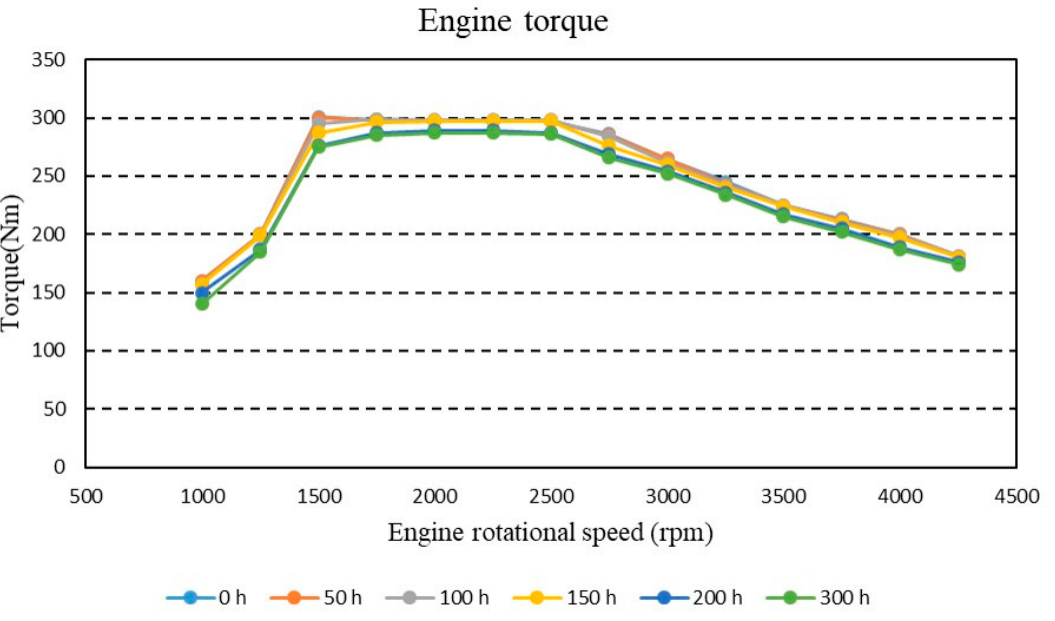
Figure 15. Changes in the engine torque during the 300 h durability test.